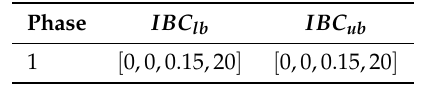
Table 2. Initial boundary condition (IBC) of the optimization